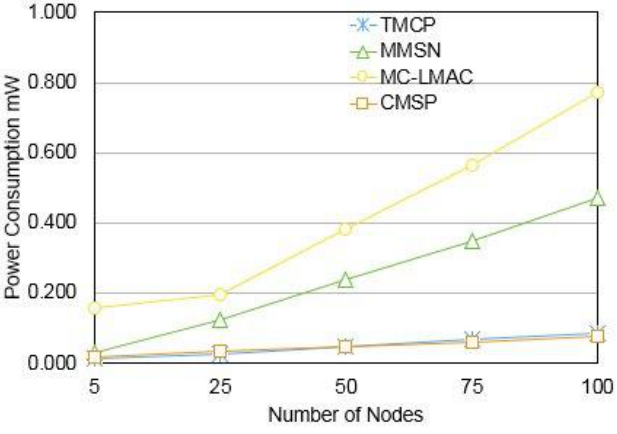
Figure 4. Power consumption vs. number of nodes.